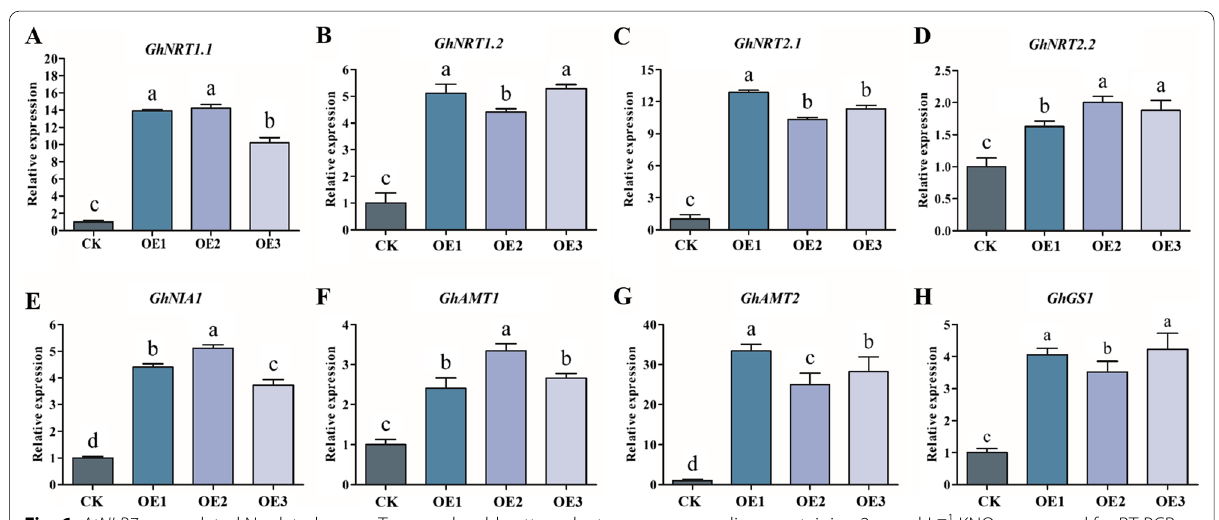
Fig. 6 AtNLP7 upregulated N-related genes. Two-weeks-old cotton plants grown on medium containing 2 mmol analysis of GhNRT1.1 ( A ), GhNRT1.2 ( B ), GhNRT2.1 ( C ), GhNRT2.2 ( D ), GhNIA1 ( E ), GhAMT1 ( F ), GhAMT2 ( G ), GhGS1 ( H ). GhHis3 was used as internal control. Results are average values SD (n 3 replicates). Letters denote significant differences ( P < 0.05) from Duncan’s multiple range ± =